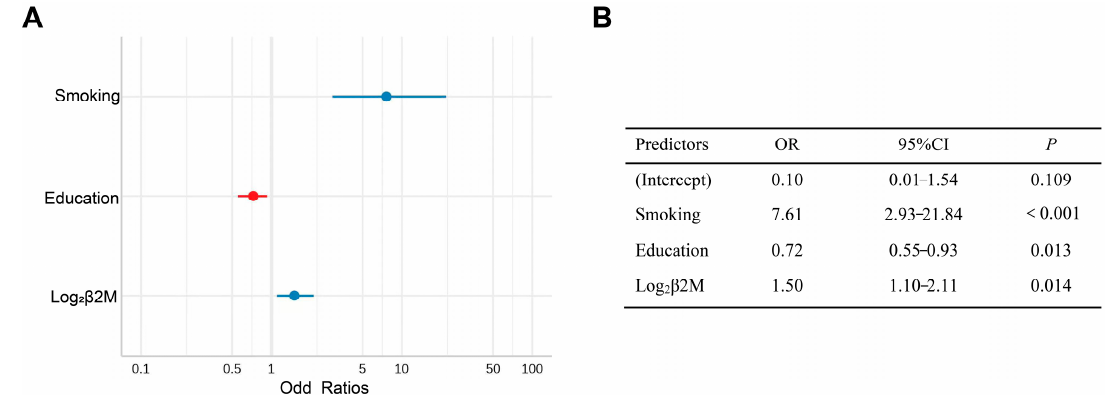
Figure 3. ( A ) Forest plot of the Multivariate logistics regression of risk factors for cognitive impair- ment. ( B ) Multivariate logistic regression analysis of risk factors for cognitive impairment.